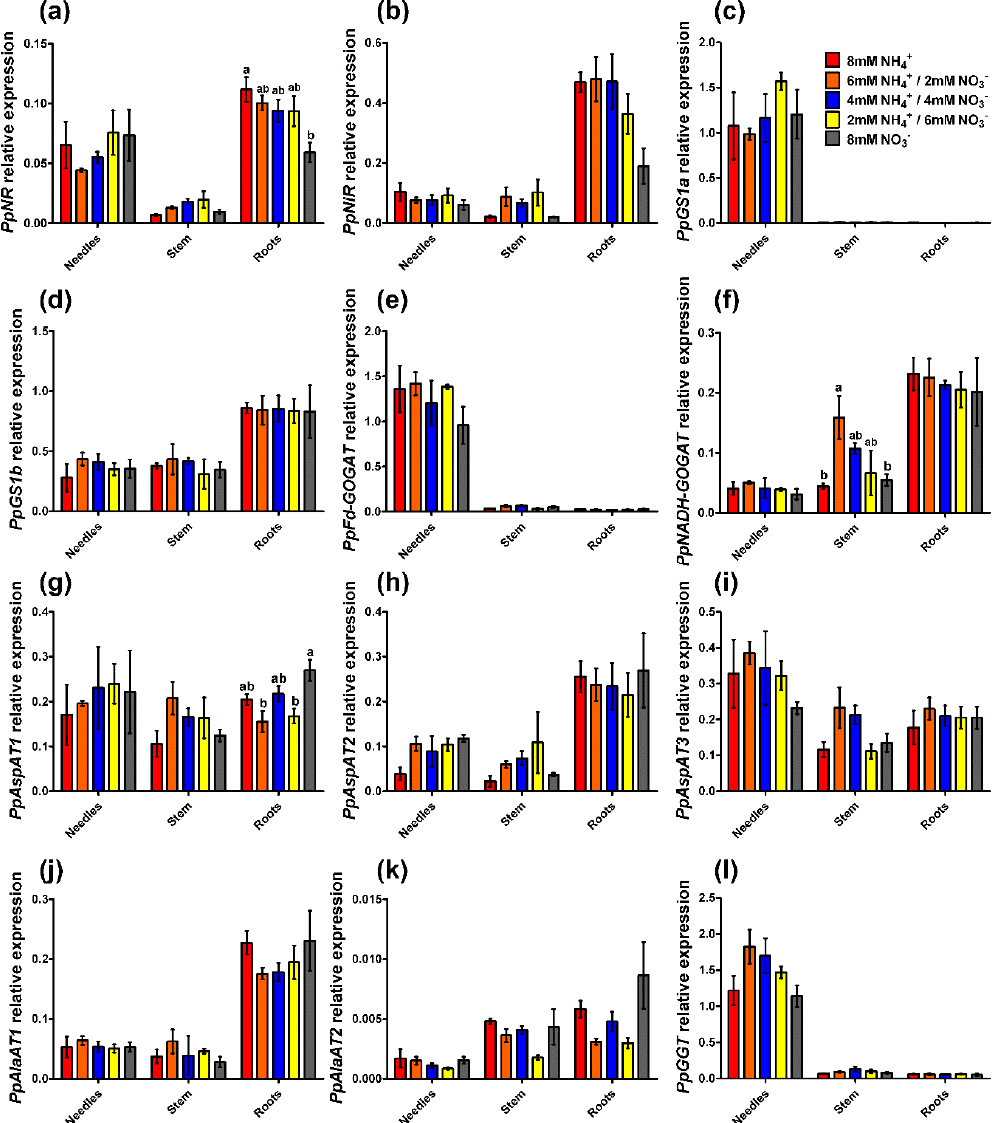
Figure 5. Gene expression profiles in the different organs (needles, stem, and roots) of pine seedlings under the nutrient treatments. ( a ) Nitrate reductase ( PpNR ); ( b ) Nitrite reductase ( PpNiR ); ( c ) Glutamine synthetase 1a ( PpGS1a ); ( d ) Glutamine synthetase 1b ( PpGS1b ); ( e ) Ferredoxin dependent glutamate synthase ( PpFd-GOGAT ); ( f ) NADH-dependent glutamate synthase ( PpNADH-GOGAT ); ( g ) Aspartate aminotransferase 1 ( PpAspAT1 ); ( h ) Aspartate aminotransferase 2 ( PpAspAT2 ); ( i ) Aspartate aminotransferase 3 ( PpAspAT3 ); ( j ) Alanine aminotransferase 1 ( PpAlaAT1 ); ( k ) Alanine aminotransferase 2 ( PpAlaAT2 ); ( l ) Glyoxylate-glutamate aminotransferase ( PpGGT ). Red columns correspond to 8 mM NH 4+ supply; orange columns correspond to 6 mM NH 4+ /2 mM NO 3 − supply; blue columns correspond to 4 mM NH 4+ /4 mM NO 3- supply; yellow columns correspond to 2 mM NH 4+ /6 mM NO 3 − supply; grey columns correspond to 8 mM NO 3 − supply. Significant differences were determined with a one-way ANOVA for each organ or entire seedling. Letters above the columns show significant differences based on a Newman-Keuls post-hoc test ( p < 0.05). Error bars show SE with n = 3.